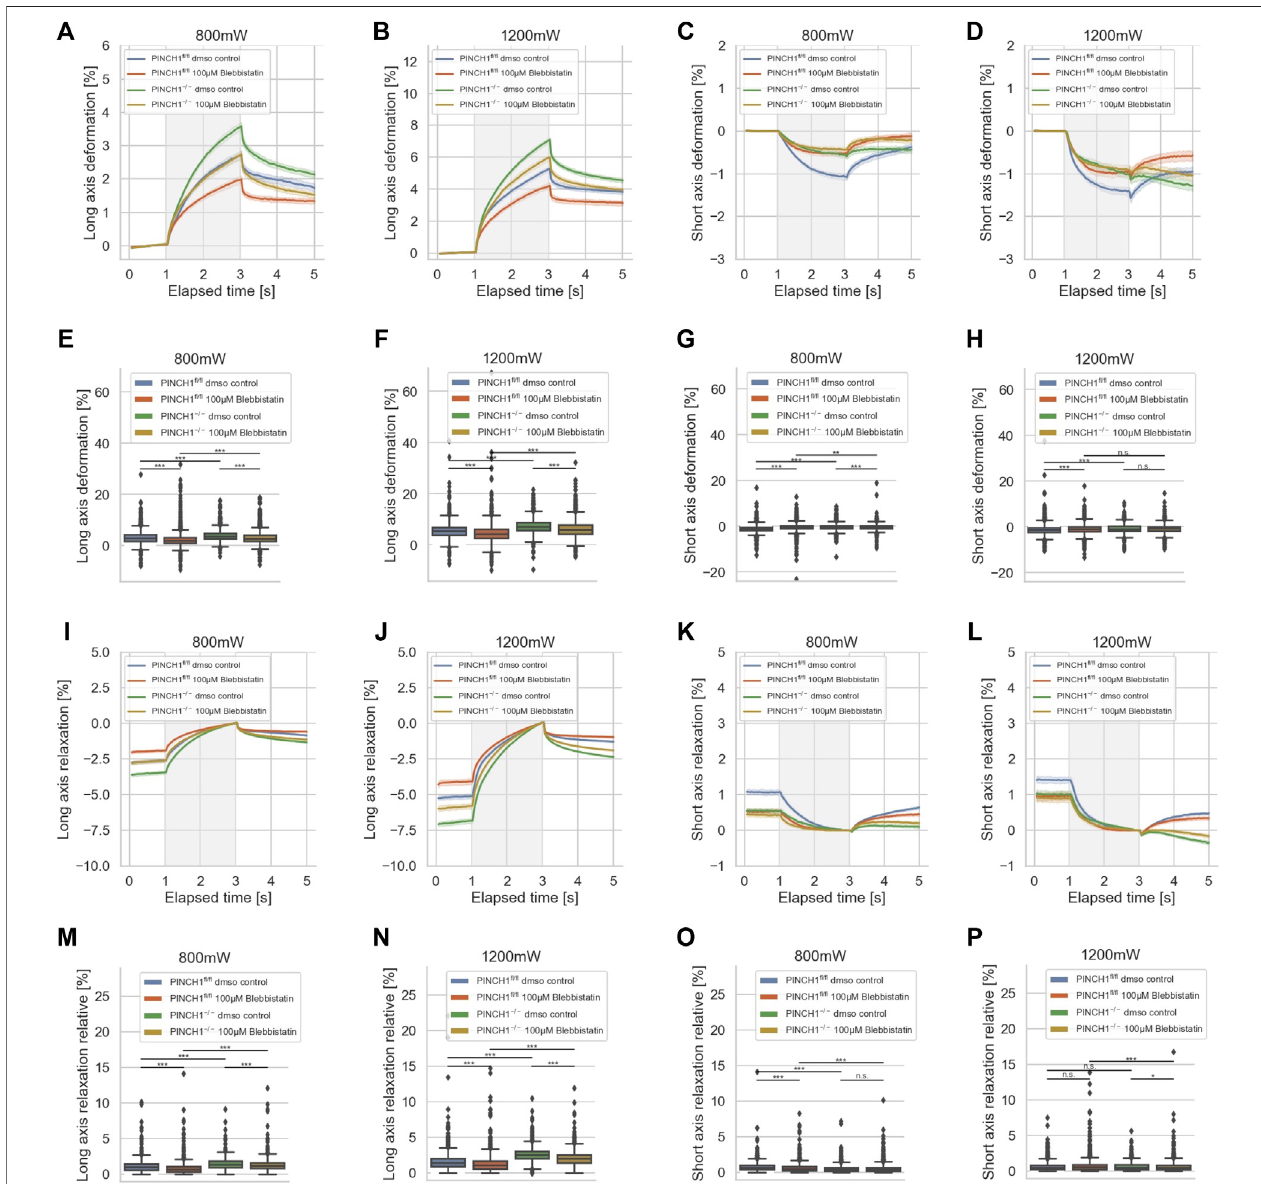
FIGURE 6 | Impact of Blebbistatin on the deformability of cells. Cellular deformability of PINCH1 − / − cells and PINCH1 fl / fl cells were measured in the presence of Blebbistatin at 800 mW (median values, n = 1,657 cells for PINCH1 − / − cells (yellow) and n = 1,568 cells for PINCH1 fl / fl cells (red)) and at 1,200 mW (median values, n = 1,633 cells for PINCH1 − / − cells (green) and n = 1,498 cells for PINCH1 fl / fl cells (blue)) and in the absence of Blebbistatin at 800 mW (median values, n = 1,708 cells for PINCH1 − / − cells(green)and n =1,706cellsforPINCH1 fl / fl cells(blue),respectively)andat1,200 mW(medianvalues, n =1,744cellsforPINCH1 − / − cells(green)and n =1,656cellsforPINCH1 fl / fl cells(blue))usinganopticalcellstretcher.ThedeformabilitycurvesofPINCH1 − / − cellsandPINCH1 fl / fl cellsattheirlongaxis (A,B) ,andshort axis (C,D) with/without Blebbistatin treatment. Maximal deformability of PINCH1 − / − cells and PINCH1 fl / fl cells at laser powers of 800 – 1,200 mW at their long (E,F) and short axis (G,H) in the presence or absence of Blebbistatin treatment. After the stretching process, the viscoelastic relaxation is observed for 2 s (I – P) . Relaxation behaviorcurvesofthelongaxisforPINCH1 − / − cellsandPINCH1 fl / fl cellsatlaserpowersof800 mW (I) and1,200 mW (J) with/withoutBlebbistatintreatment. (K,L) Short axis relaxation curves of PINCH1 − / − cells and PINCH1 fl / fl cells at the two laser powers with/without Blebbistatin treatment. (M,N) Maximal relaxation (at time point 3 s, where the deformation is maximal) of PINCH1 − / − cells and PINCH1 fl / fl cells at the two laser powers at their long axis with/without Blebbistatin treatment. (O,P) Maximal relaxation of PINCH1 − / − and PINCH1 fl / fl cells at the two laser powers at their short axis with/without Blebbistatin treatment. (A – D, I – L) Data are presented as median values with a 95.0% con fi dence interval (E – H, M – P) data are presented as box and whiskers plots (Q2 represent median values). (A – P) The experiments have been conducted as 4 to 6 independent repetitions. (*** p < 0.001, ** p < 0.01, * p < 0.05, n.s. = not signi fi cant; Kruskal-Wallis test).